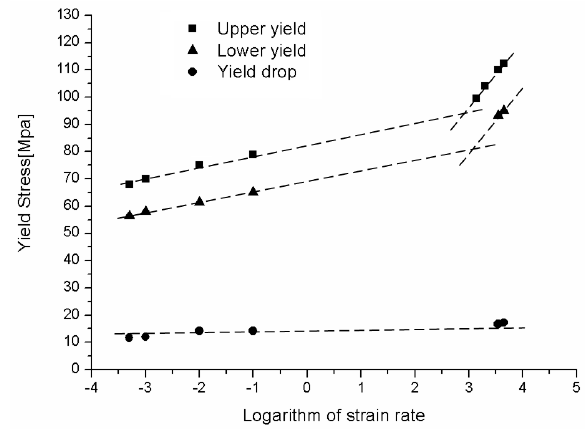
Figure 9. Strain softening behavior of PC for different strain rates.